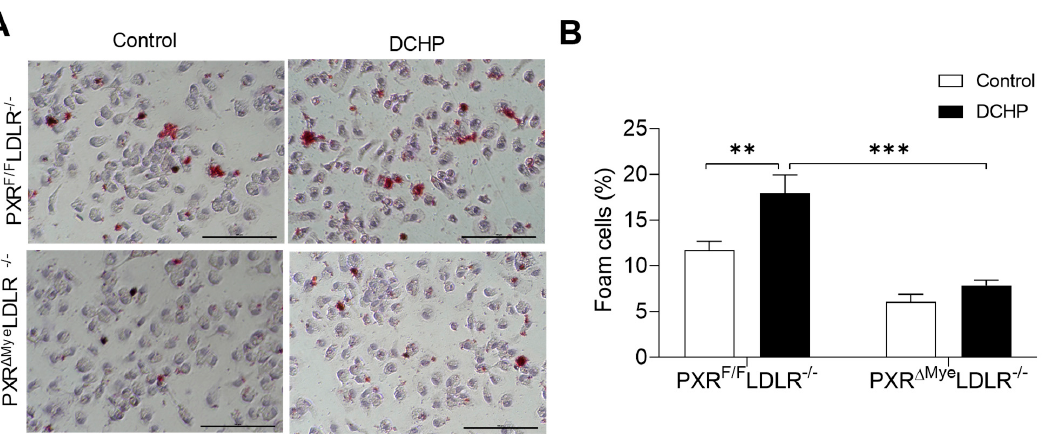
Figure 4. Deficiency of PXR reduces DCHP ‐ induced macrophage foam cell formation. Four ‐ week ‐ old male PXR F/F LDLR − / − and PXR Mye LDLR − / − littermates were treated with 10 mg/kg/day of DCHP or vehicle control daily by oral gavage for 12 weeks. ( A ) Peritoneal macrophages were isolated and stained with Oil Red O and hematoxylin (scale bars = 100 μ m), ( B ) Foam cell quantification from peritoneal macrophages in studies described in panel A. Data are represented as mean ± SEM (n = 3, ** p < 0.01, and *** p < 0.001).